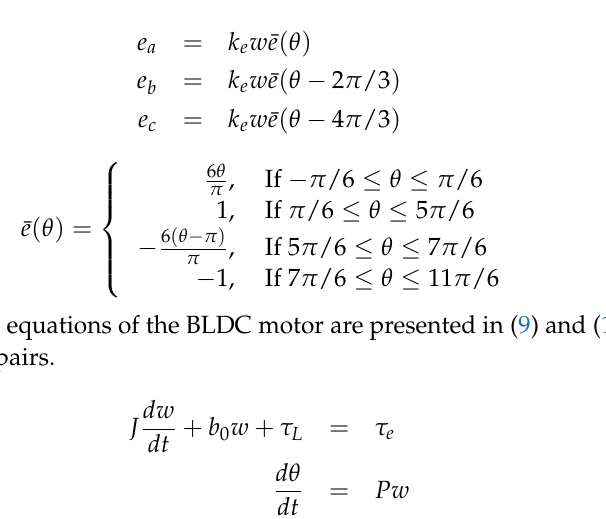
Figure 2. Switching sequence (SS) at each point of the inverter. The trapezoidal back-EMF force e γ is described by (5)–(7), where k e is the back-EMF constant of the motor and ¯ e ( θ ) is related to the trapezoidal shape function (due to switch- commutation logic for BLDC motors) displayed in